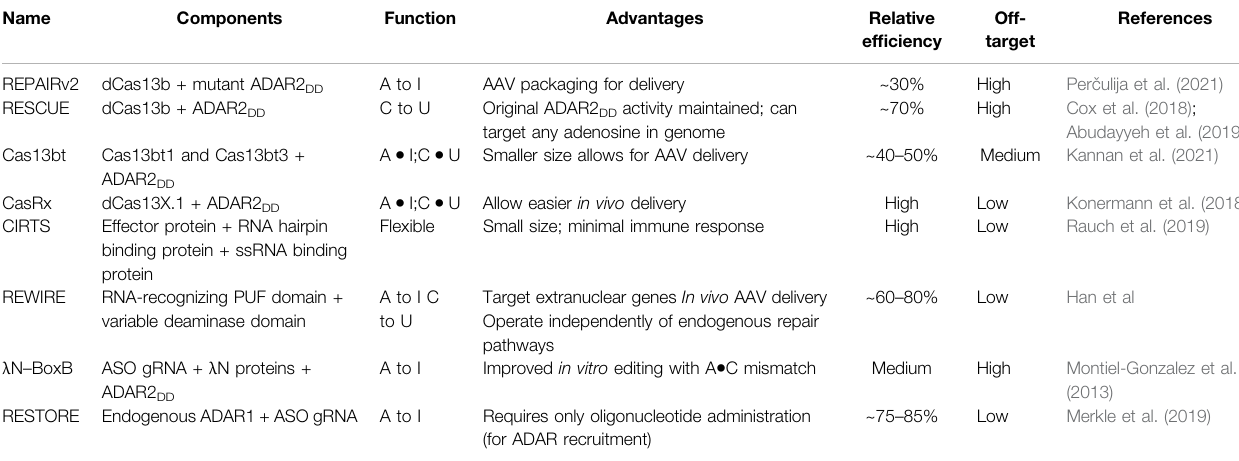
TABLE 1 | Comparison of various RNA-targeting systems for base